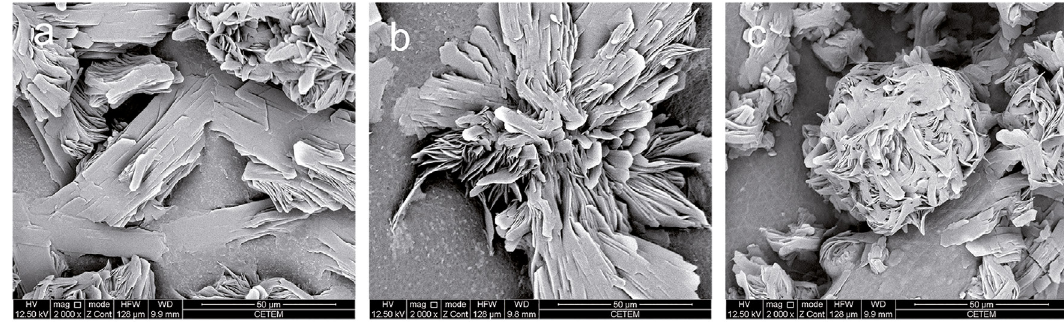
Figure 8. SEM images for PVA/CS mats at 70:30 (M3, a), 75:25 (M4, b) and 85:15 (M6, c) compositions, after immersion in water. temperature range studied. The E’ values recorded at 25ºC were 34 MPa, 128 MPa and 167 MPa for M6, M4 and